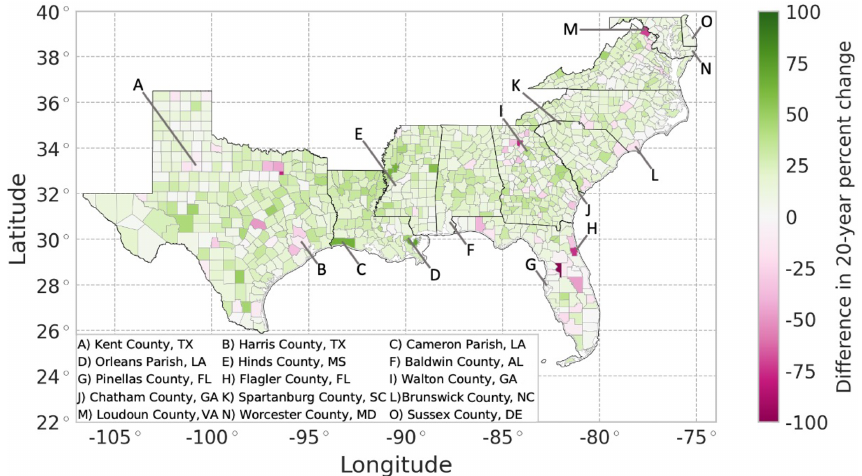
Figure 8. Projected 20-year housing acceleration (projected percent change in housing units between 2019 and 2039, minus the percent change of housing units between 1999 and 2019) using the REACH20 model. The green color represents an acceleration, and pink represents a deceleration.